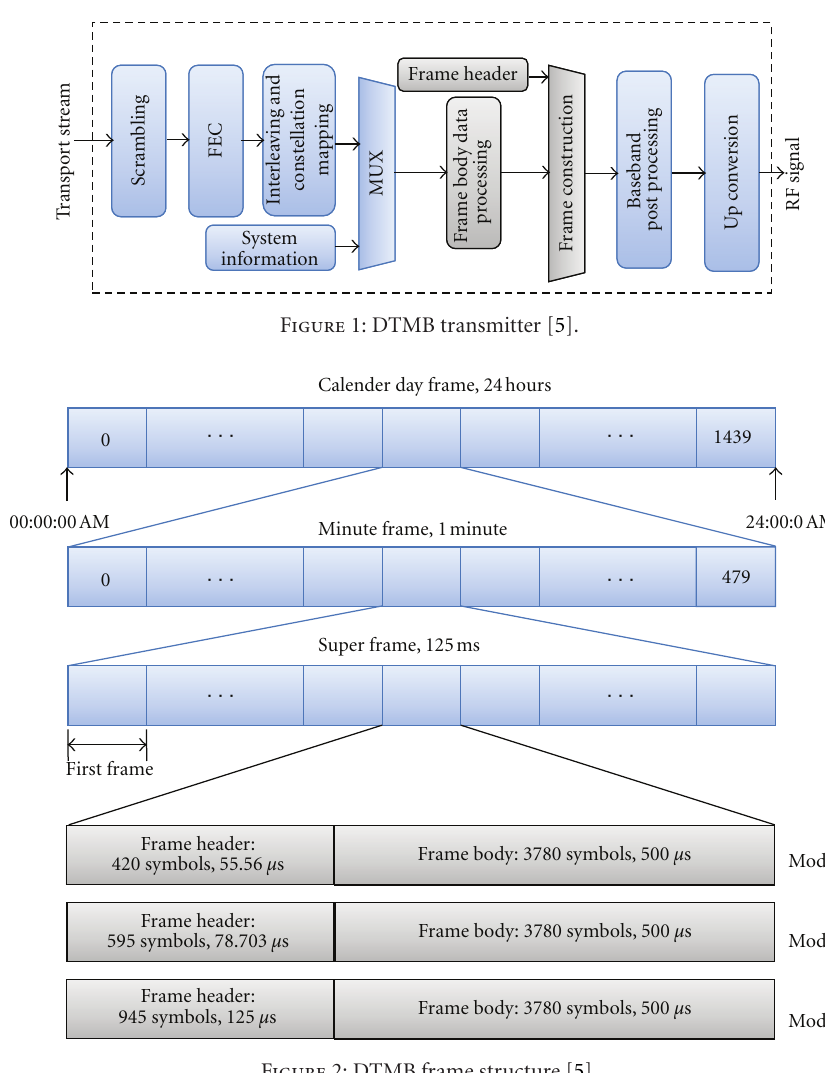
Figure 2: DTMB frame structure [5].